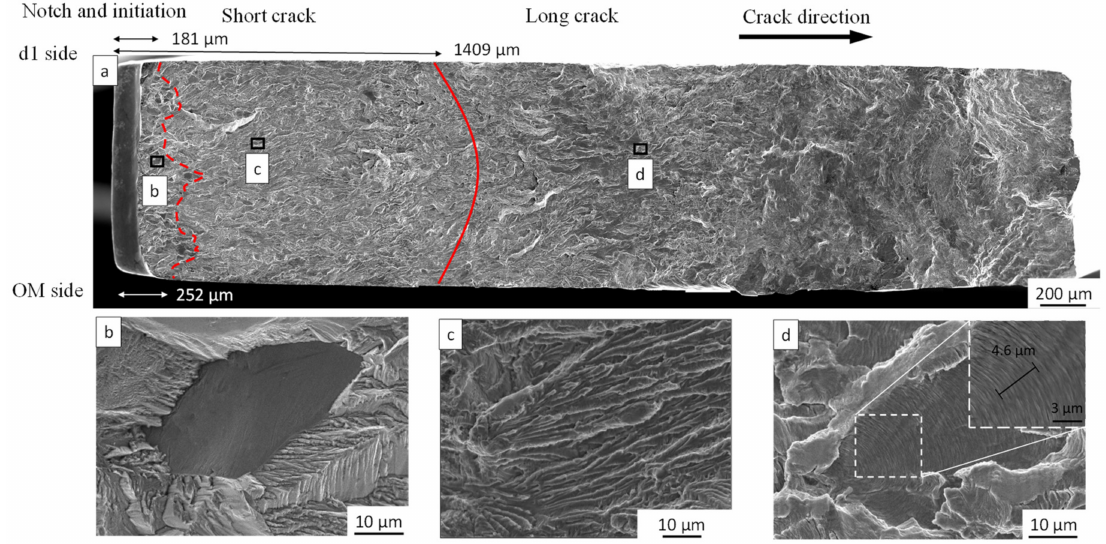
Figure 7. SEM observations on the fracture surface after final failure. ( a ) Full scale of fatigue crack surface. The red dashed and solid lines delimit the boundaries between the initiation and the short cracking, and the short cracking and the long cracking. ( b ) The intergranular cracking at the initiation stage. ( c ) The ridge patterns during the short crack stage. ( d ) The classic striations pattern in the stable propagation stage with a crack growth of about 0.46 µ m/cycle.